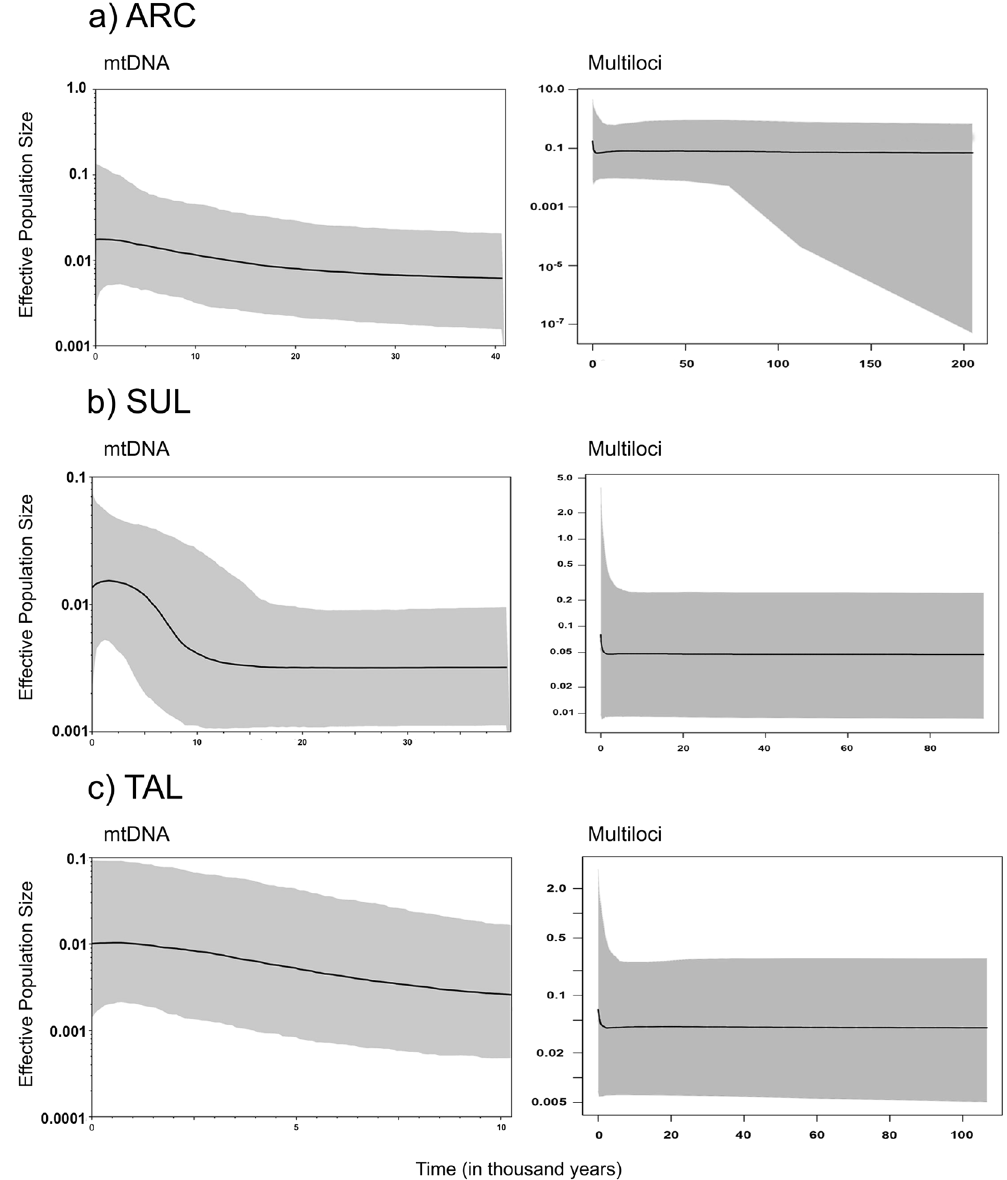
Figure 4. Extended Bayesian skyline plot for mtDNA (left) and multiloci (right) data for each main clade of C . typus : ARC ( a ), SUL ( b ) and TAL ( c ). The bold line indicates the median whereas the grey area represents the 95% confidence interval. The dates were calibrated with COI substitution rate and are shown in thousands of years before